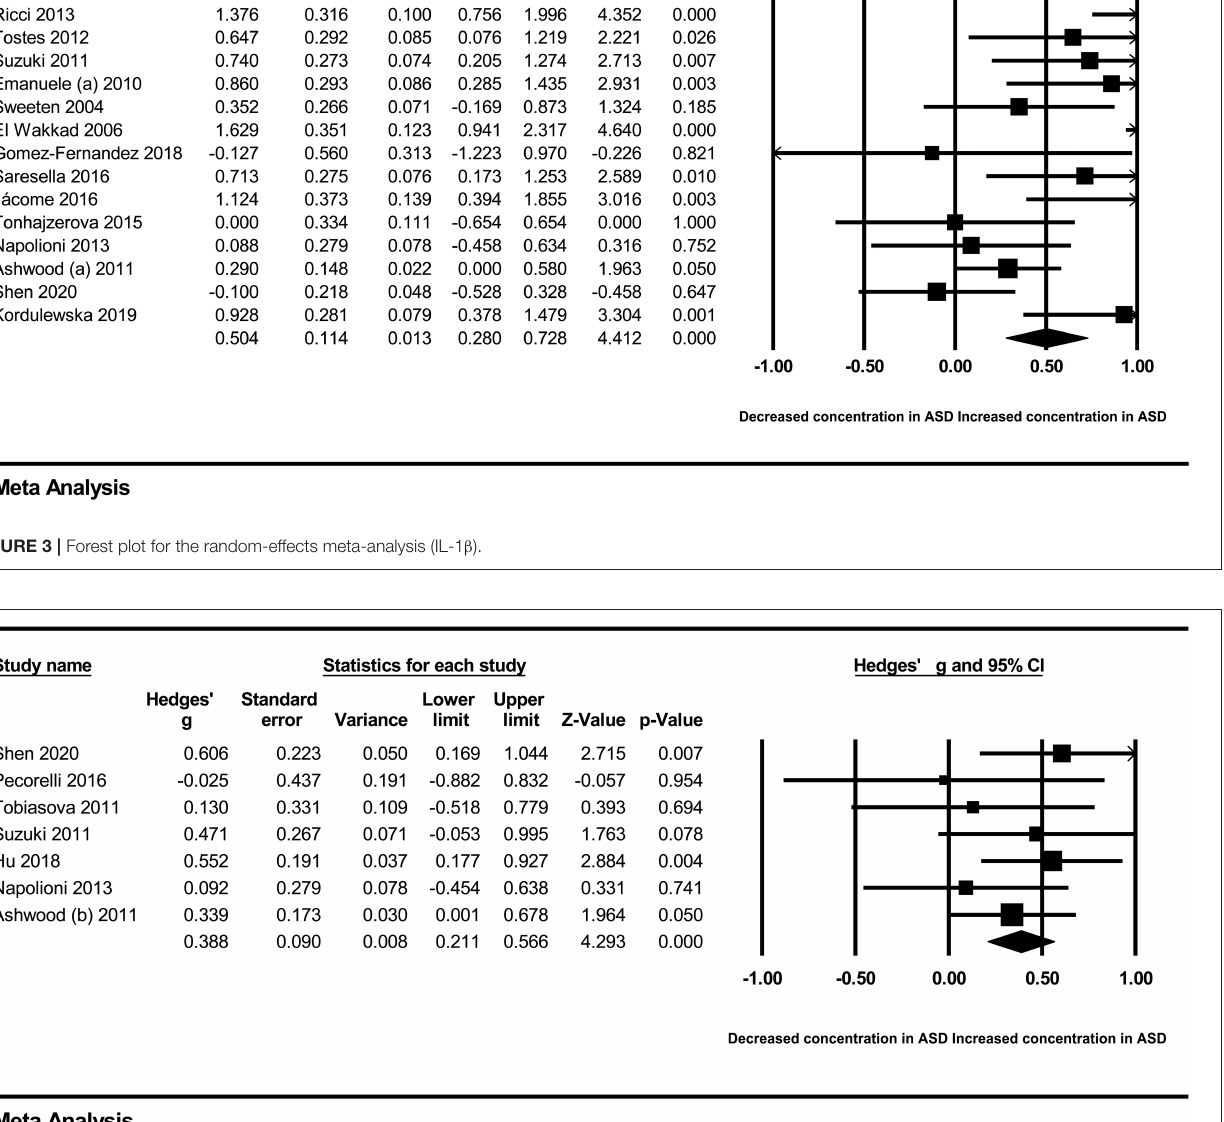
FIGURE 4 | Forest plot for the fixed-effects meta-analysis